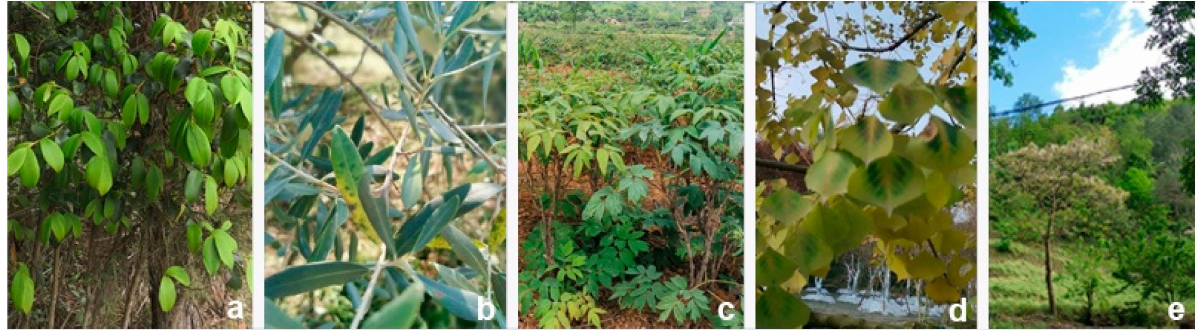
Figure 1. Hosts of pestalotiod species collected in this study ( a ) Camellia oleifera , ( b ) Olea europaea , ( c ) Paeonia suffruticosa , ( d ) Sapium sebiferum , ( e ) Vernicia fordii